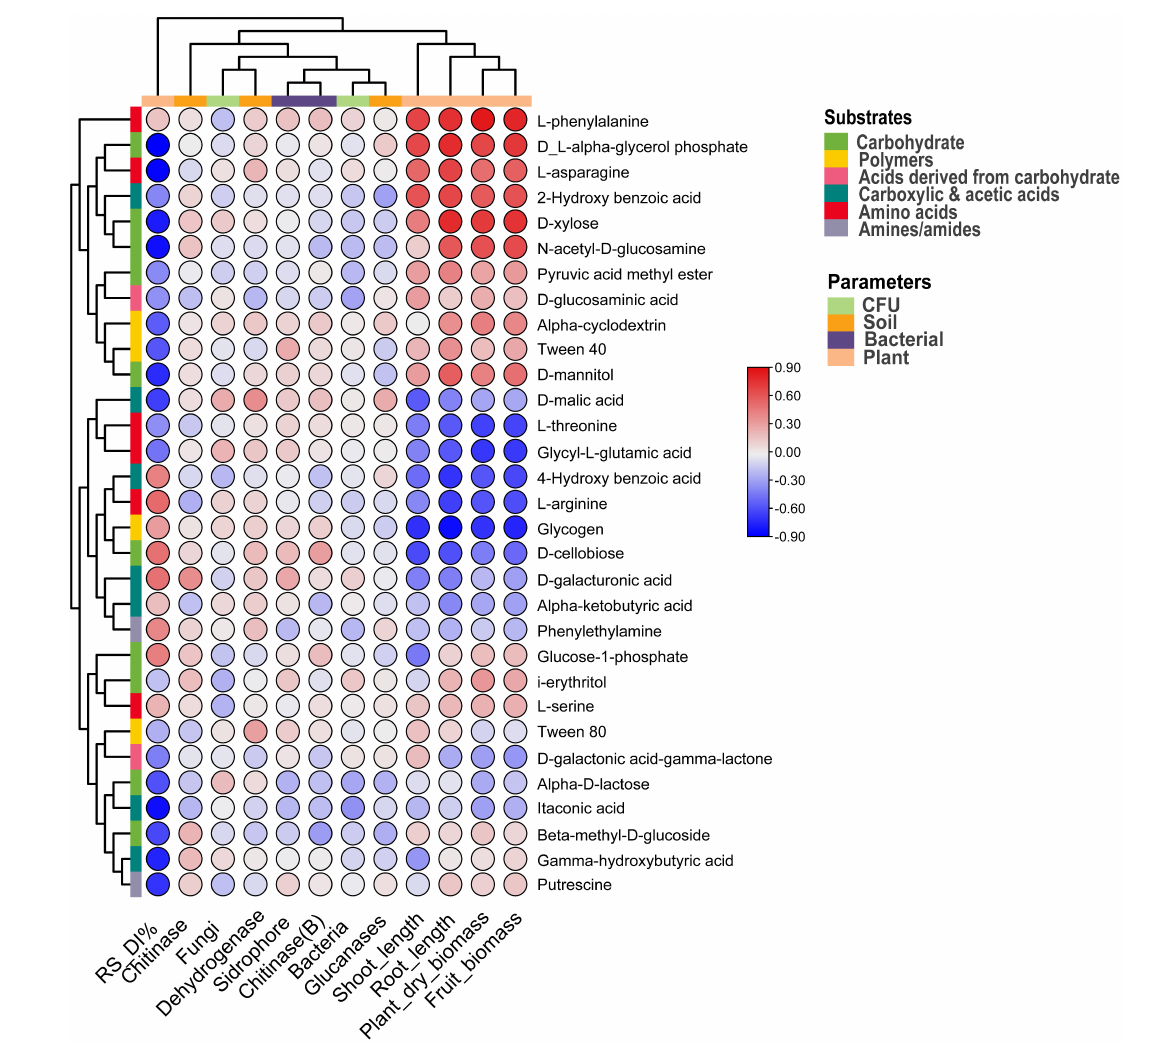
FIGURE6 Correlation heatmap between soil and plant parameters and carbon substrates under pathogen and antagonist treated soil. Positive correlation indicated via red and negative via blue